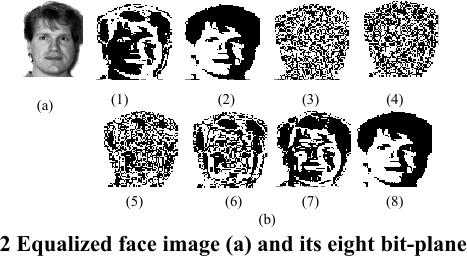
Fig. 2 Equalized face image (a) and its eight bit-planes